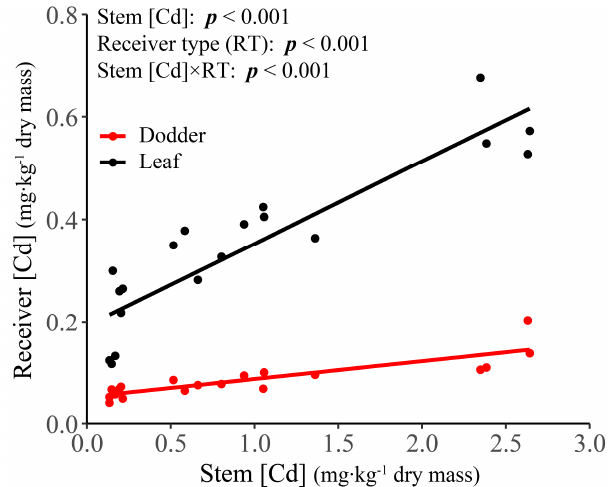
Figure 3. The correlations of cadmium concentration ([Cd]) between soybean stem (source) and its receiver (sink) components (i.e., soybean leaf and dodder). In the analysis (i.e., nested ANCOVA), stem [Cd] covariate, receiver component type and their interaction term were the fixed factors, and pot replicate was the random factor. The results are presented here as p values of fixed factors, which were calculated based on type-III analysis-of-variance.